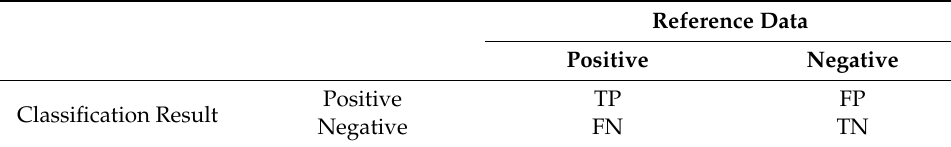
Table 4. Conceptualization of a binary classification confusion matrix. TP = True Positive, TN = True Negative, FP = False Positive, and FN = False